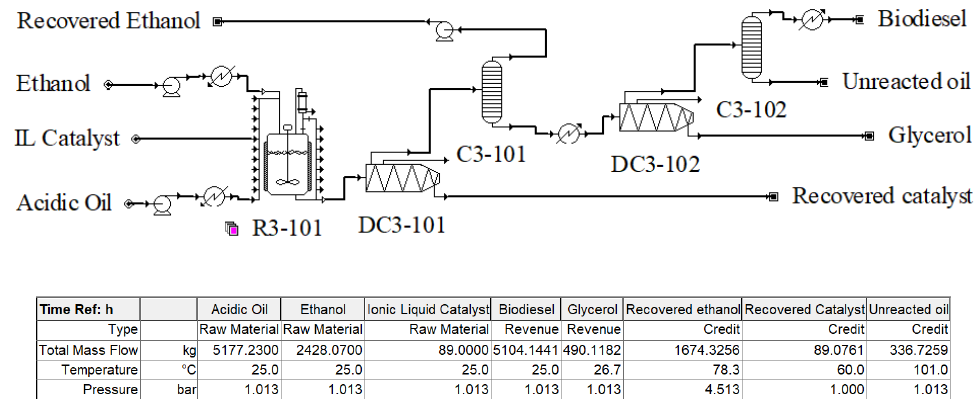
Figure 3. Technology option III: R3-101 CSTR for the production of biodiesel, DC3-101 first centrifugal decanter to recover the catalyst, C3-101 first distillation column to recover excess ethanol, DC3-102 second centrifugal decanter to separate the glycerol, and C3-102 second short cut distillation to purify the biodiesel.